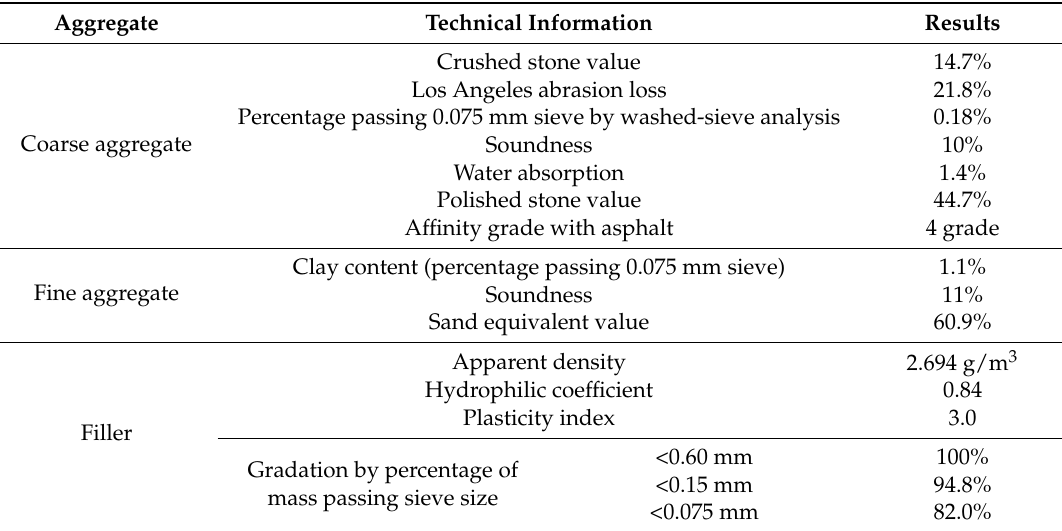
Table 3. Technical information on aggregates and